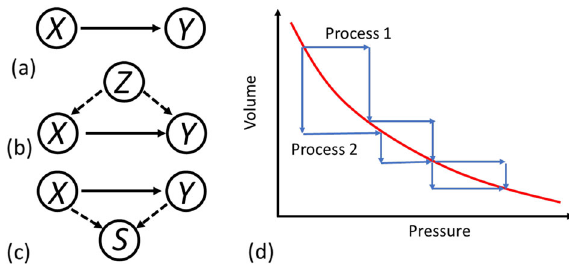
Fig. 2 Understanding causal links in the presence of confounding effects and observational biases. a Correlation can be used to analyze causative mechanisms only if there is a well-de fi ned causal link between the variables. In the presence of ( b ) confounders or ( c ) observational bias analysis of correlations can result in fundamen- tally incorrect conclusions. For example, the correlation of the